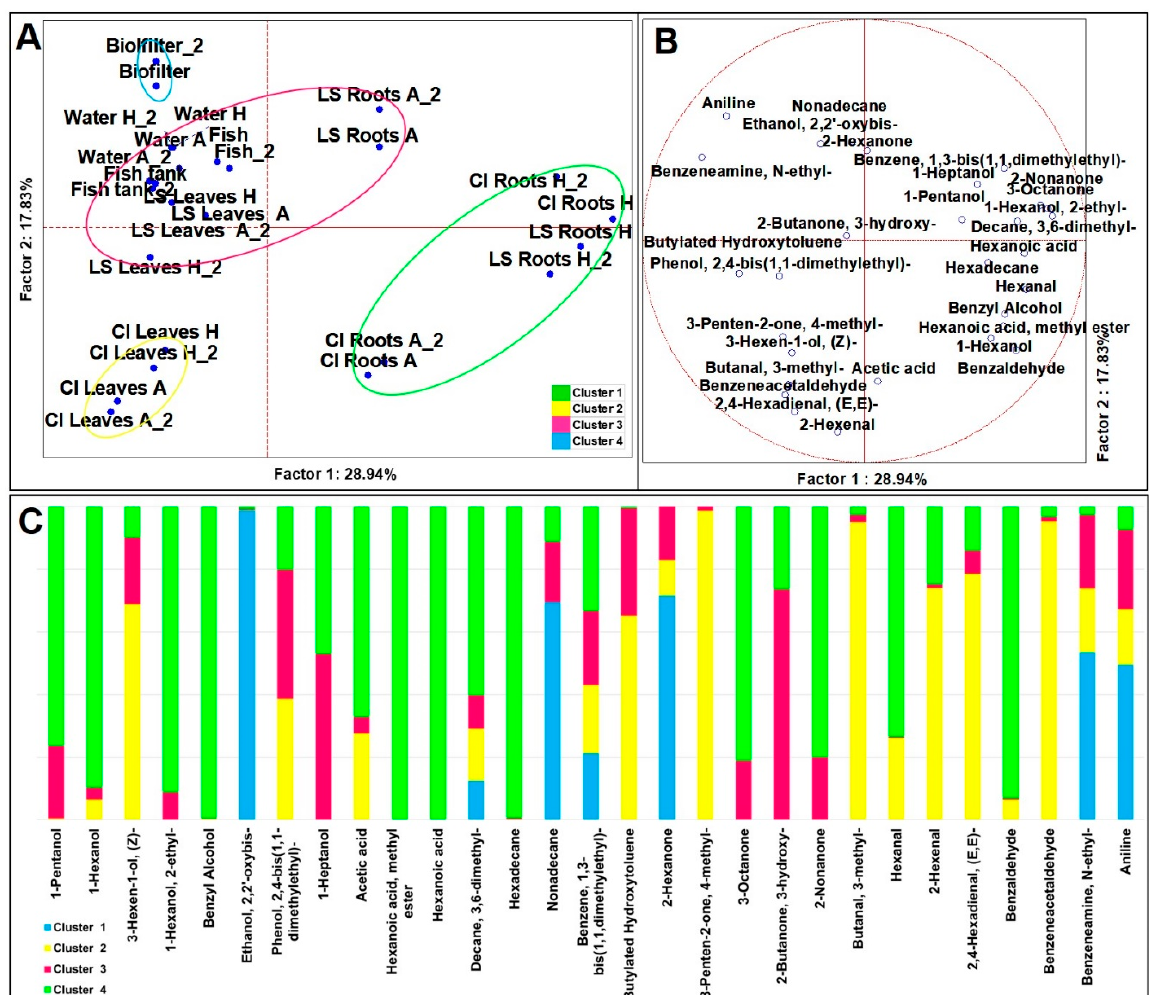
Figure 1. Principal Component Analysis (PCA) of cases ( A ) and variables ( B ) on VOCs; ( C ) K-means cluster analysis (at least p < 0.05).